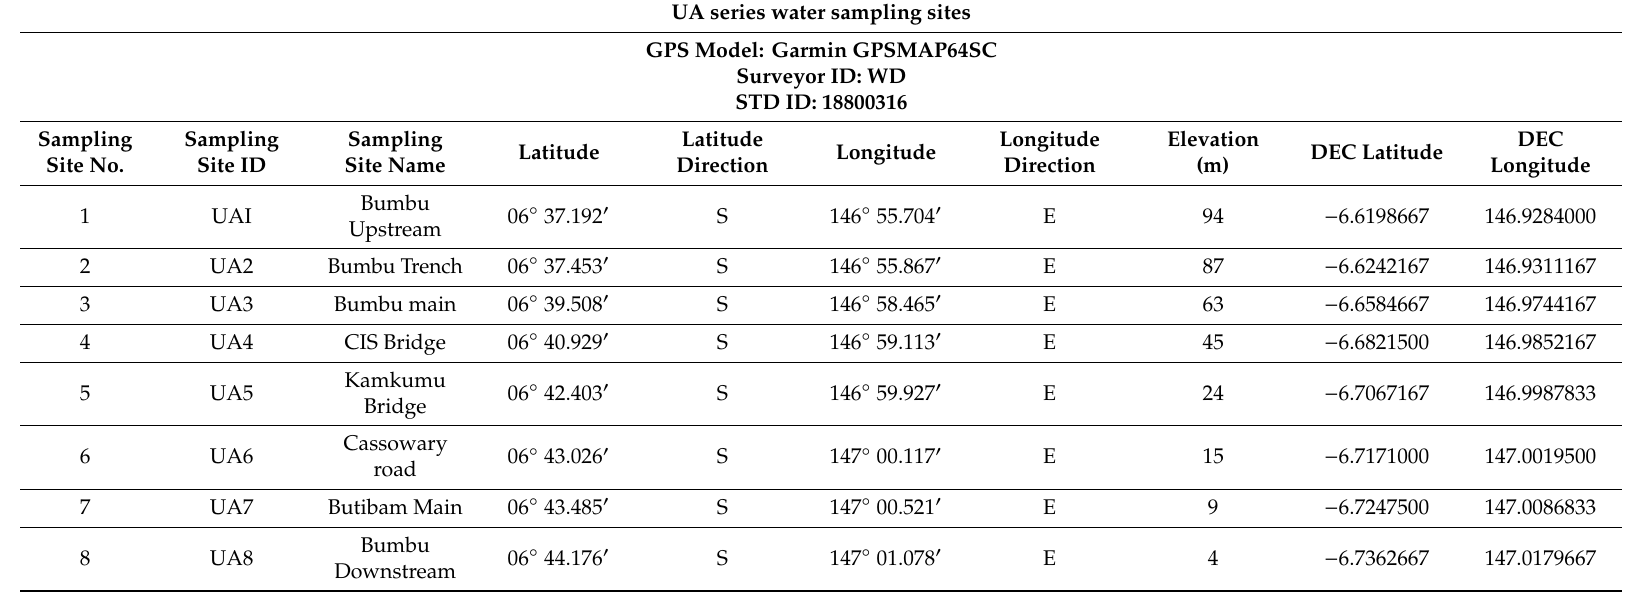
Table A1. GPS survey of the 8 water sampling sites of UA